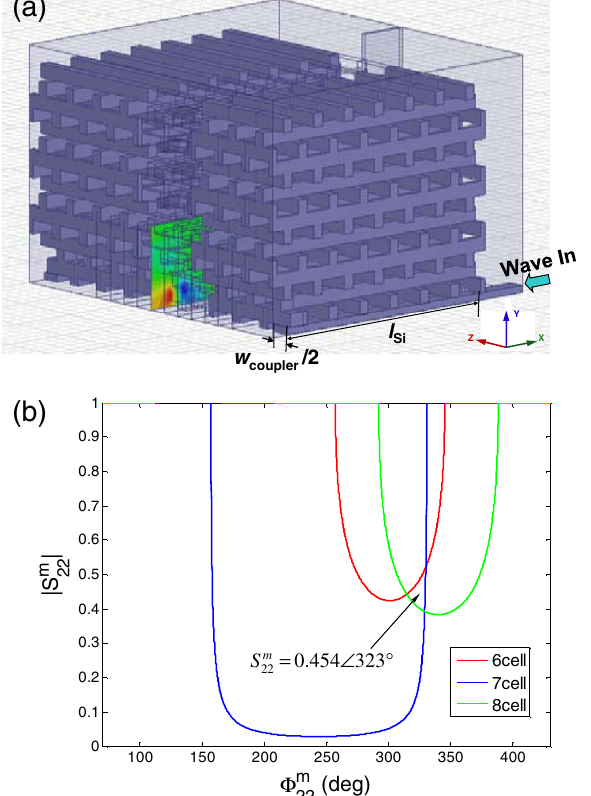
FIG. 9. (a) TE-to-TM mode power coupler design for the new accelerating mode, and (b) its multiple-cell simulation results to determine the required S 22 m for traveling-wave match.